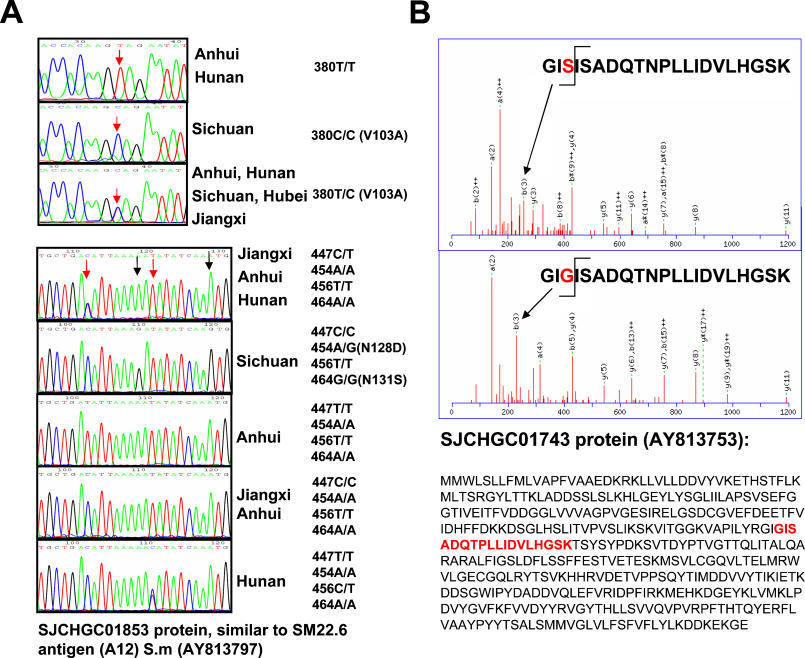
Validation of Potential SNPs by RT-PCR and MS/MS Spectra(A) The SNPs of the putative SM22.6 antigen (A12) were checked by re-sequencing of PCR products amplified from genomic DNA samples of field-collected isolates of S. japonicum obtained from five Chinese provinces, as indicated at the right. The SNPs indicated by the red arrows were identical to the findings based on EST data in this study, and the SNP sites indicated by black arrows were not identified by us, according to the stringent criteria employed. Substitutions of amino acid residues due to the missense mutations are illustrated based on the DNA sequences.(B) An example for the verification of the translated peptide variants due to nonsynonymous SNPs by MS/MS spectra. The amino acid S (serine) of SJCHGC01743 protein was replaced here by a smaller amino acid G (glycine), where the b3 ion was shifted to the lower mass range as indicated by arrows. Both peptides were detected in the same protein extracts from female schistosomes by the mass spectrometry data. The position of the peptide within the protein sequence is highlighted with red color.